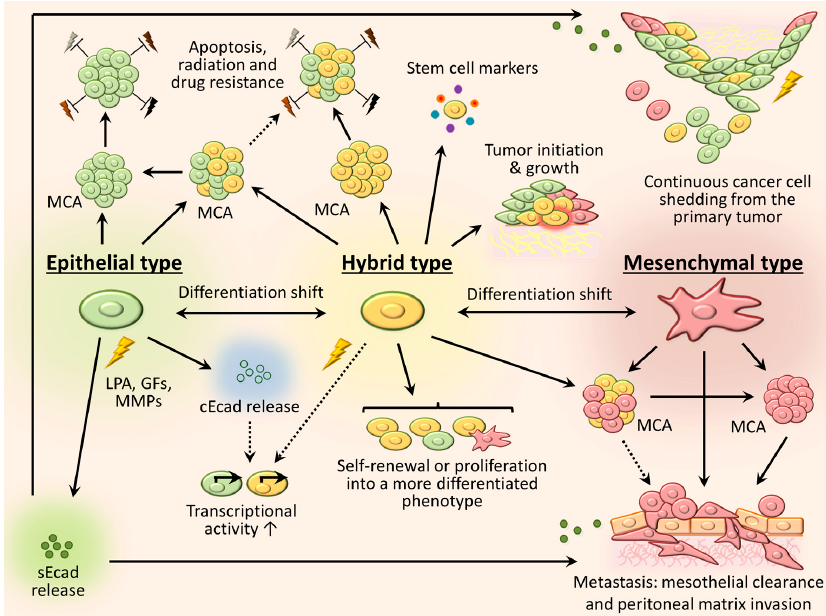
Figure 3. Phenotypic plasticity of EOC cells in the peritoneal cavity. Triggered by the soluble factors abundant in intraperitoneal fluid such as the bioactive lipid lysophosphatidic acid (LPA), growth factors (GFs), and matrix metalloproteinases (MMPs) (all designated as yellow lightening), ovarian cancer cells exist as a heterogeneous mixture of free-floating epithelial, mesenchymal and intermediate (hybrid) cells inside the peritoneal cavity. These cells can dynamically shift between phenotypes along the EMT spectrum adjusting to microenvironmental cues. Multicellular aggregation (MCA) of epithelial-type cells (green) is reported to play a pro-survival role through developing resistance to cell death, radiation and chemotherapeutics (designated grey, brown and black lightening). Bioactive molecules promote cleavage of the Ecad ectodomain to generate a soluble Ecad fragment (sEcad, green filled dots). The sEcad fragment may promote further disruption of cell- cell junctions between the epithelial and hybrid cells and enhance cell shedding from the primary tumor surface. The released Ecad cytoplasmic domain (cEcad, green open dots) may stimulate cell transcriptional activity. Mesenchymal-type cells (pink) readily form MCAs and are predominantly involved in metastasis-associated behaviors, exhibiting mesothelial cell (orange cuboid) clearance activity and peritoneal matrix invasion. Additionally, cell invasion may be amplified by stimuli from sEcad. The hybrid cells (yellow) retain stemness properties: expression of stem cell markers (colored dots), ability for self-renewal or proliferation into a more differentiated phenotype, tumor initiation (tumor-initiating cell designated red-circled) and growth. Hybrid cells may also form mixed MCAs with either epithelial or mesenchymal cells, undergo differentiation consistent with the phenotype of the adjacent cells in co-culture and share their subsequent fate. Black arrows represent